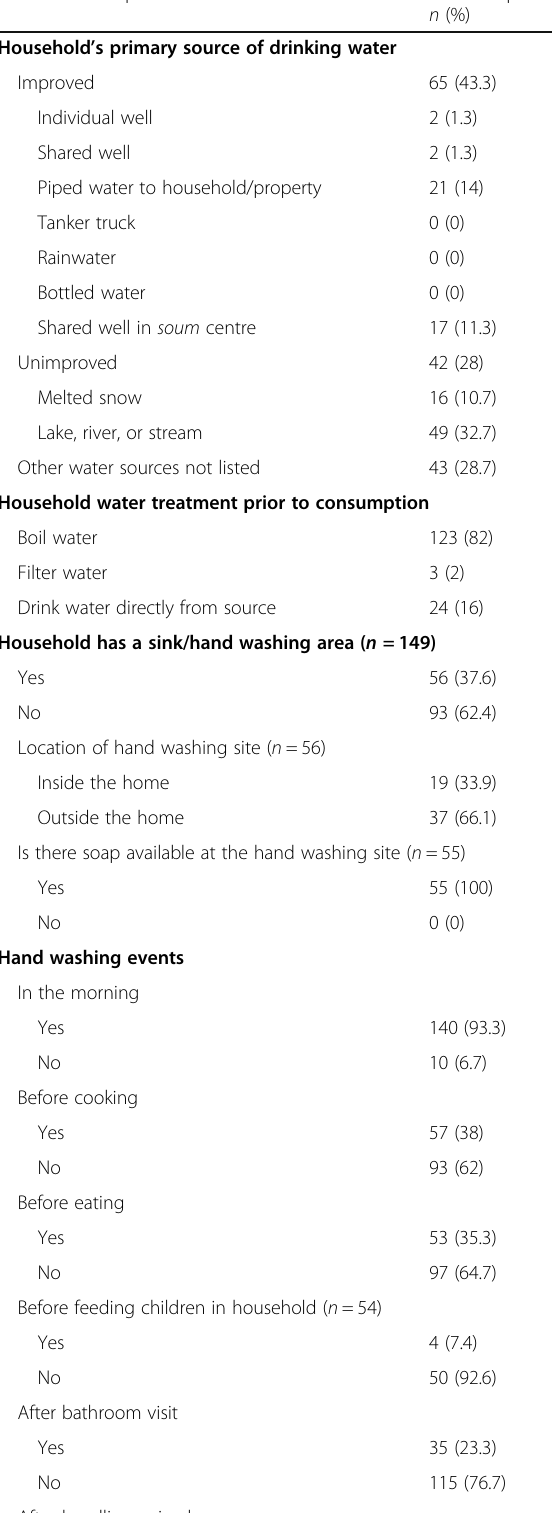
Table 2 Mongolian herding household water, sanitation, and hygiene access and behaviours ( n = 150) Variable and response